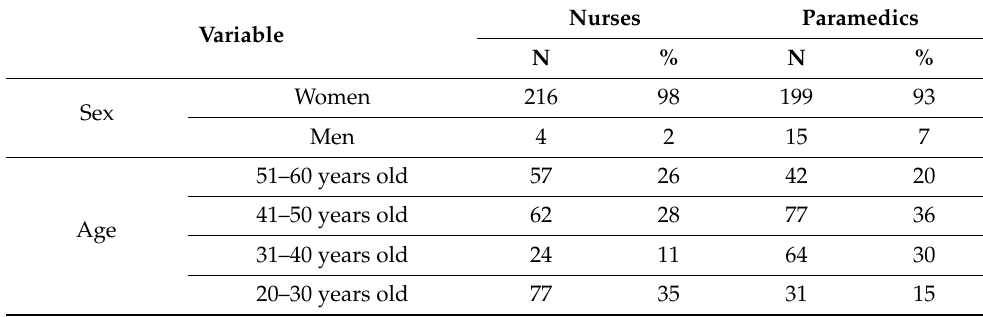
Table 1. Demographic characteristics of the respondents. (N—nurses, P—paramedics).